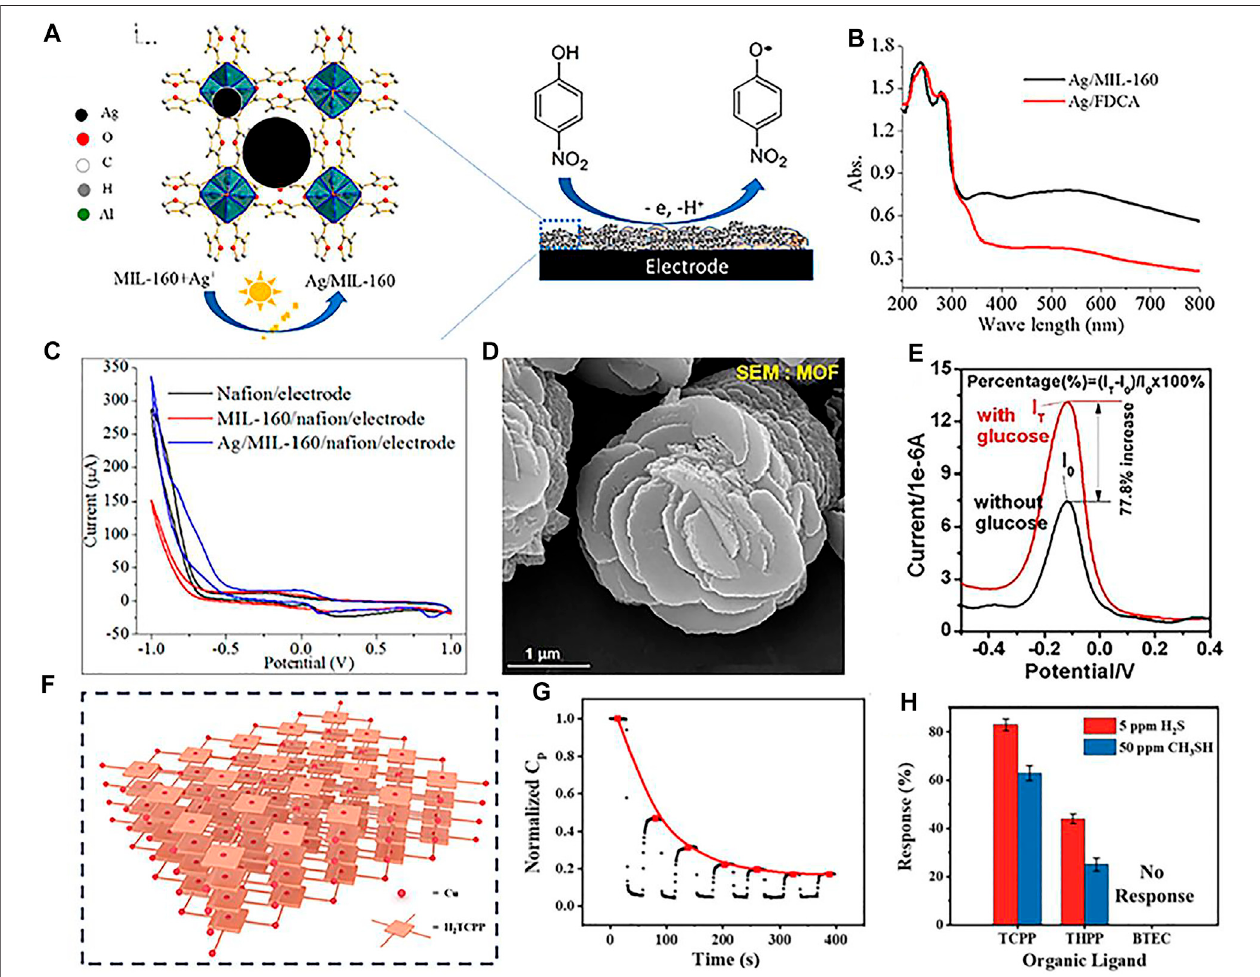
FIGURE 1 | (A) Synthetic process of Ag/MIL-160; (B) UV – vis diffuse re fl ectance spectra of prepared composites; (C) CV curves of different electrodes at a scan rate of 50 mV s − 1 in an electrolyte with p -NP. Reproduced with permission (Liu et al., 2019). Copyright 2019, ACS. Scanning electron microscope (SEM) image (D) and DPV responses without and with 4 mM glucose (E) of Cu(II)-anchored MOFs. Reproduced with permission (Zhang et al., 2020). Copyright 2020, Elsevier. Scheme (F) , normalized capacitance response (G) of the Cu-TCPP IC-MOF sensor and (H) Cu-X IC-MOF sensors to 5 ppm H 2 S and 50 ppm CH 3 SH. Reproduced with permission (Li et al., 2021). Copyright 2020,